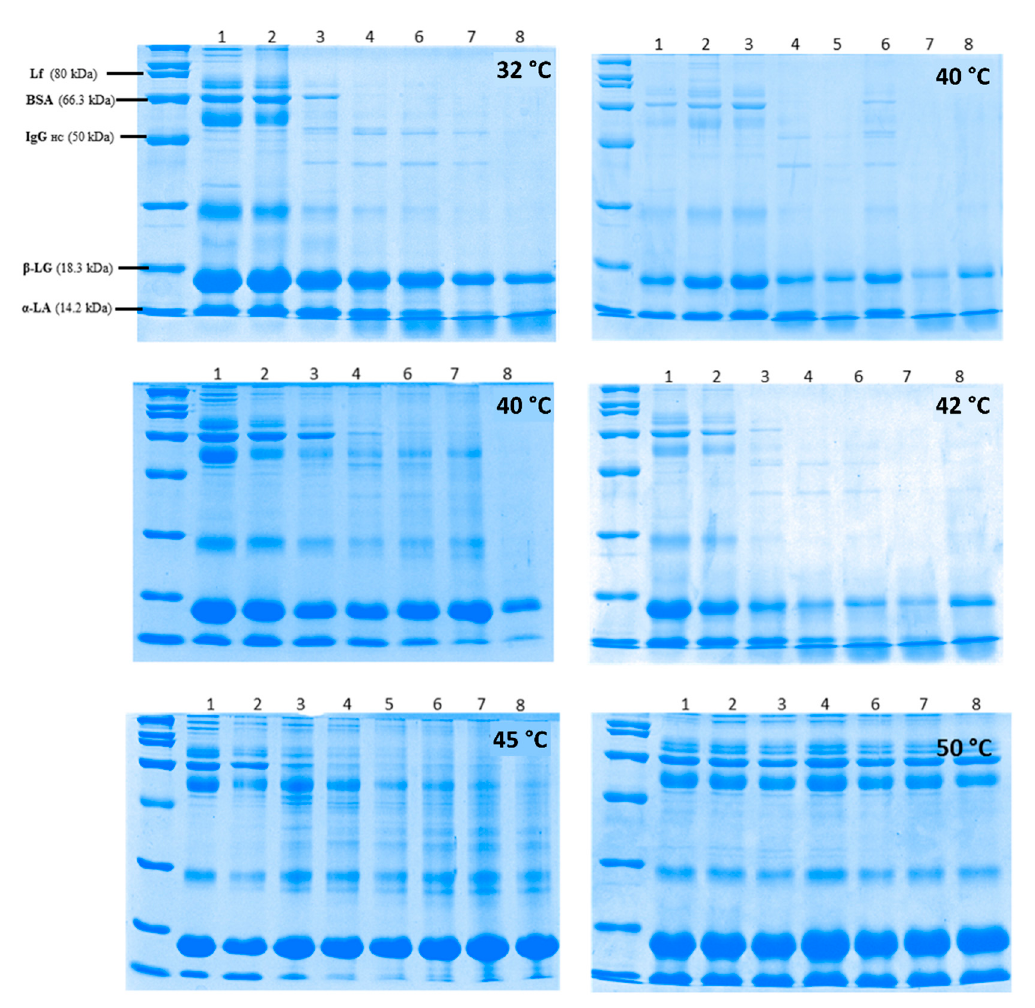
Figure 4. Electrophoretic (SDS-PAGE) protein profile of whey fermented by its native microbiota after 0, 12, 24, 48, 60, 72, 96, and 120 h (lines 1–8 respectively) at temperatures of 32, 37, 40, 42, 45, and 50 ◦